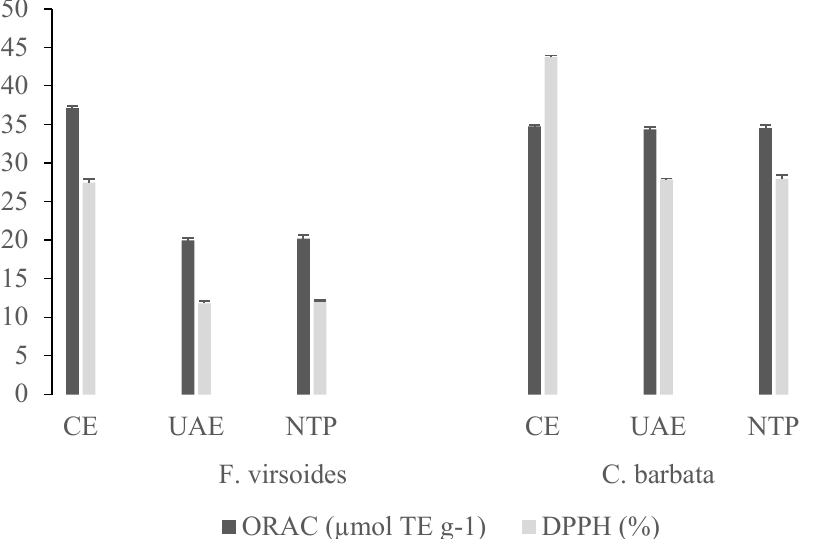
Figure 3. Antioxidant capacity of F. virsoides and C. barbata polysaccharides obtained by CE, UAE, and NTP as determined by ORAC and DPPH assays.